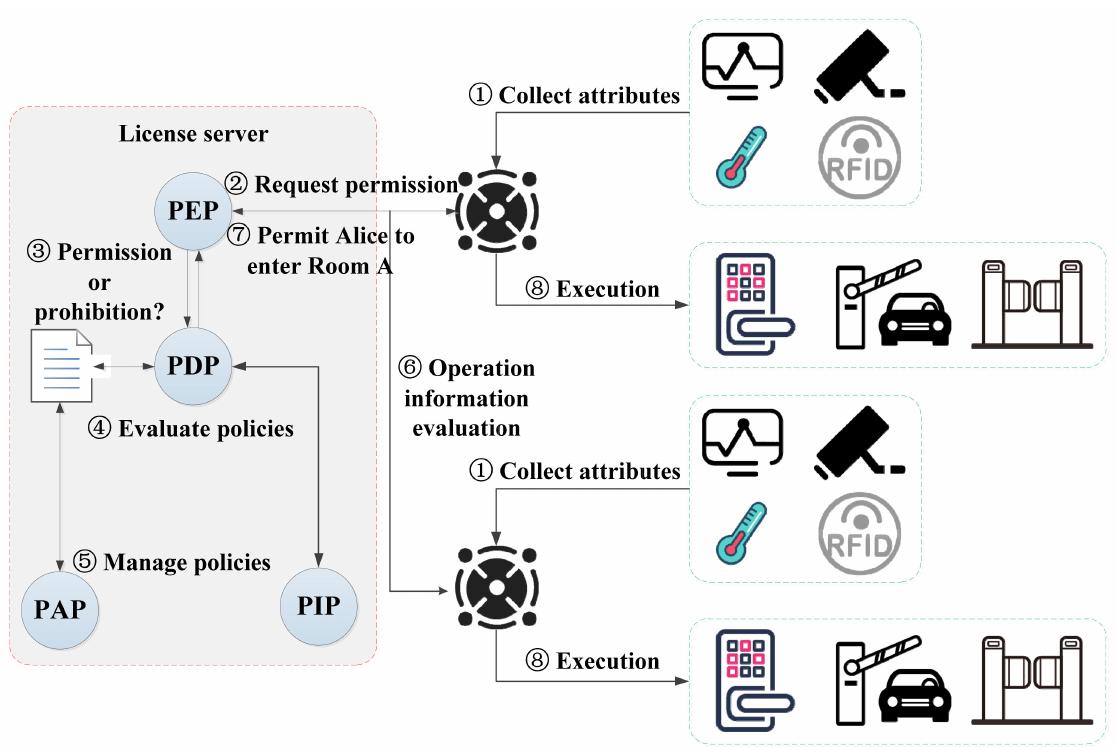
Figure 1. A sensor networks-based security control model of smart